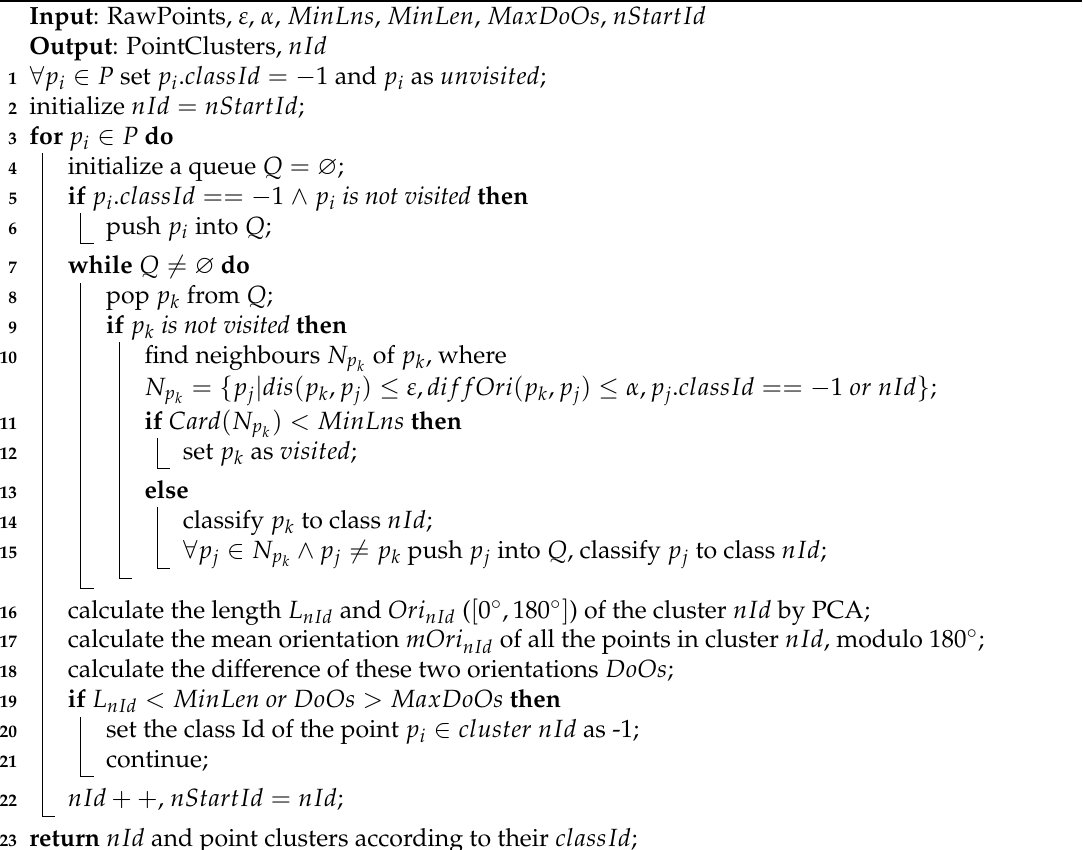
Algorithm 1: DBSCAN with an orientation